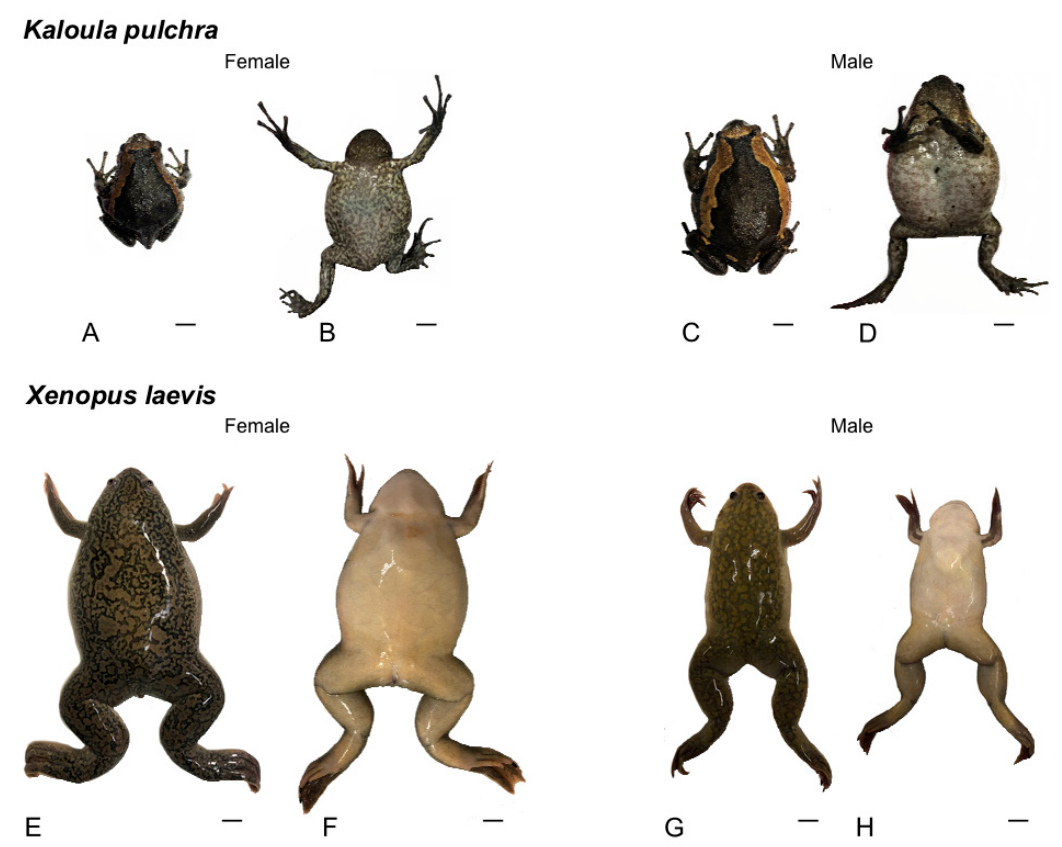
Figure 1. Photos of specimens in dorsal (left) and ventral (right) views of Kaloula pulchra ( A – D ) and Xenopus laevis ( E – H ) showing the differences between both species and females and males. Scale bars = 1